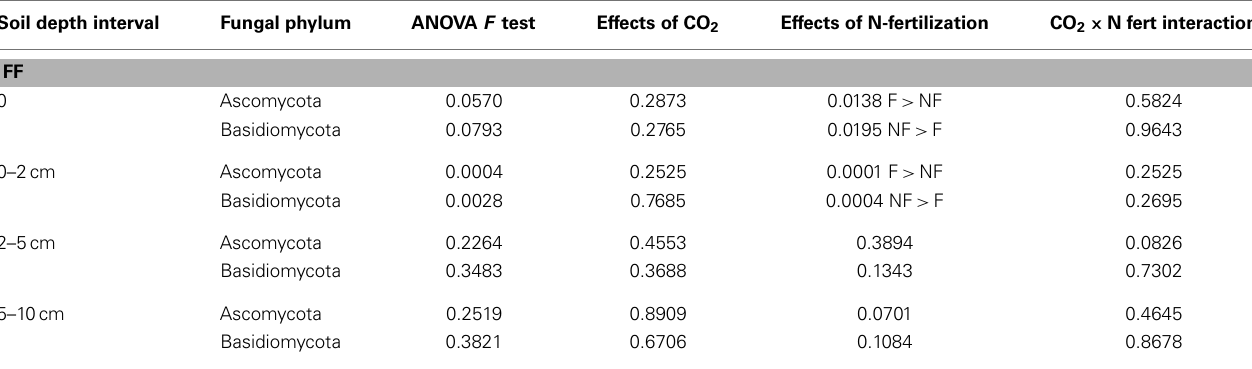
Table 5 | Changes in proportion ofAscomycota and Basidiomycota fungi after long-term elevated atmospheric CO 2 conditions, N-fertilization or the combination of treatments, at four soil depth intervals.